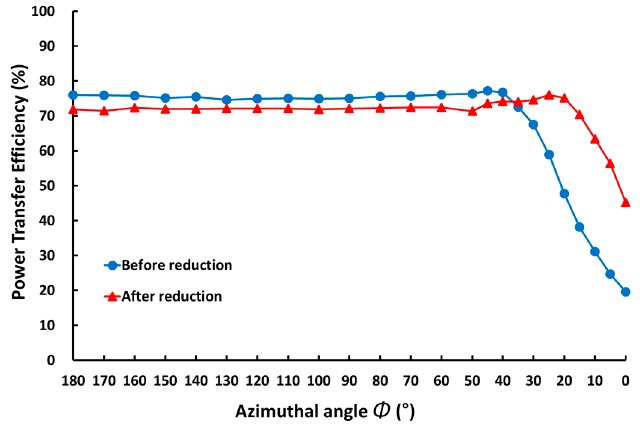
Figure 14. Experimental result: power transfer efficiency (PTE).